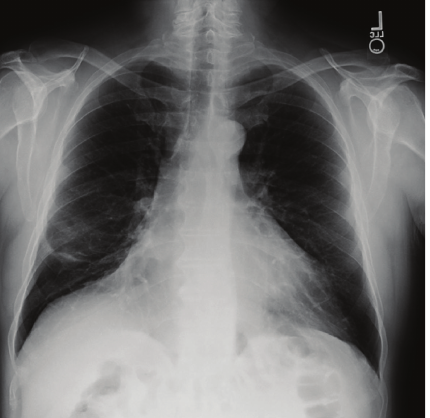
Figure 4: Chest radiograph demonstrating near-complete resolu- tion of the right middle lobe mass after treatment with corticoster-